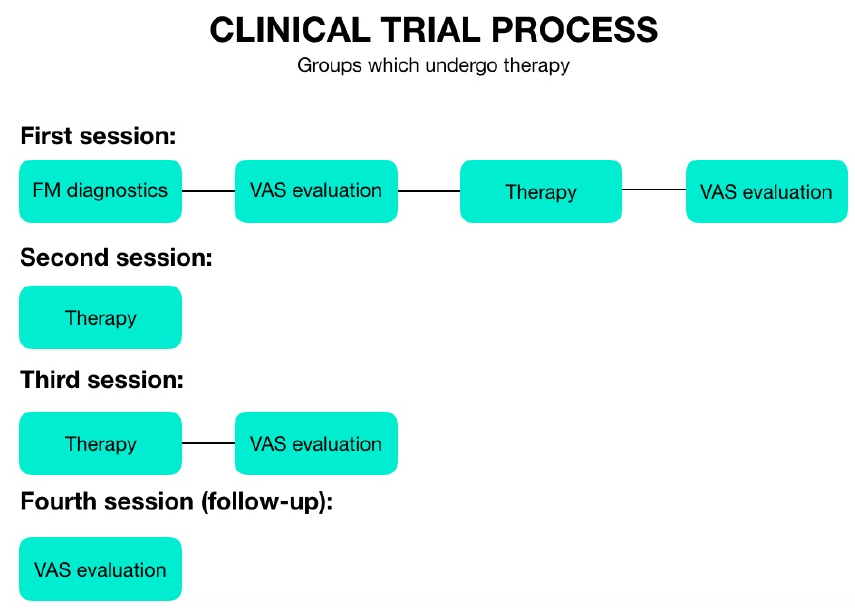
Figure 1. The examination scheme of the therapeutic groups.